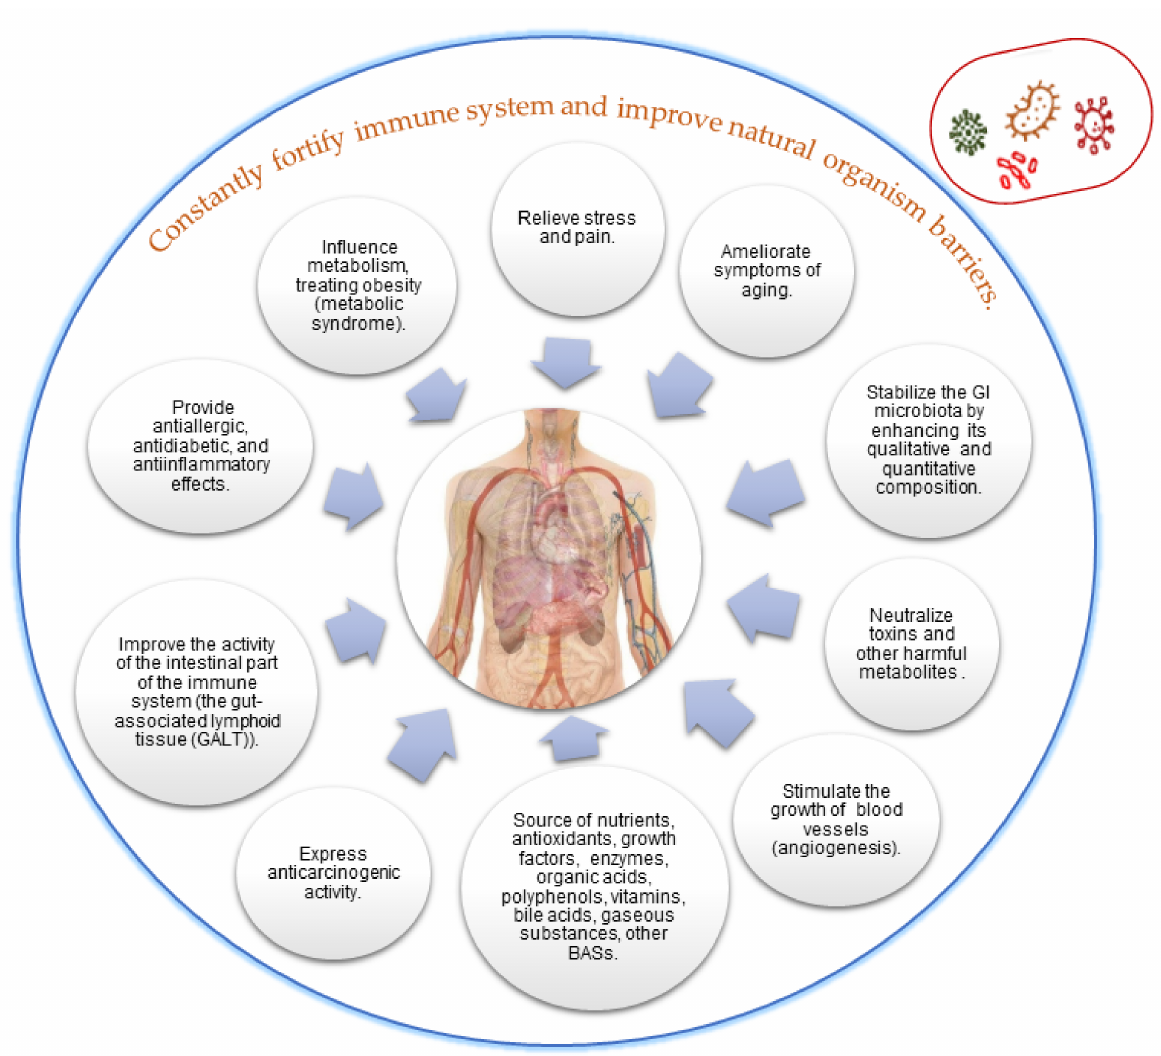
Figure 9. Health-promoting effects of metabiotics on the host organism (adapted from Oleskin at al.